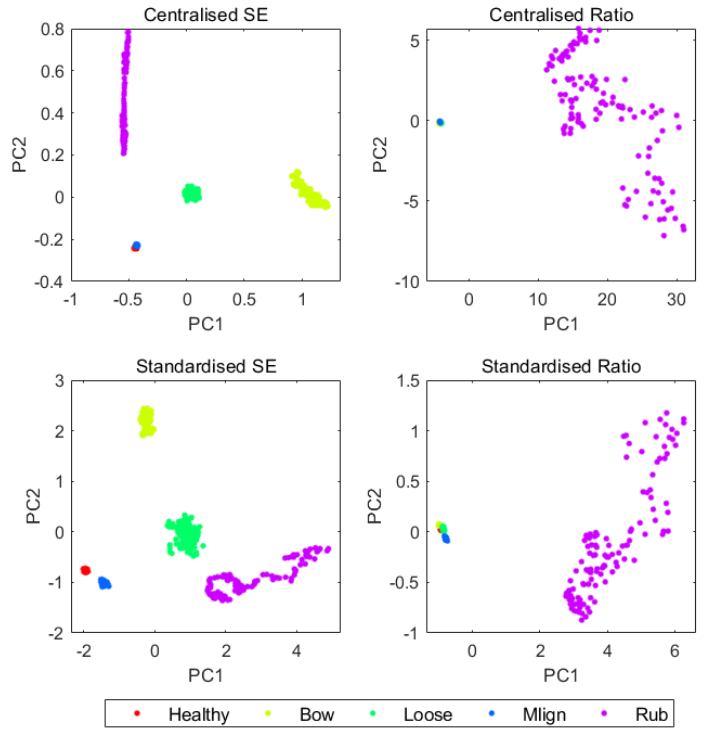
Figure 6. PCA results for four feature extraction methods at 40 Hz.